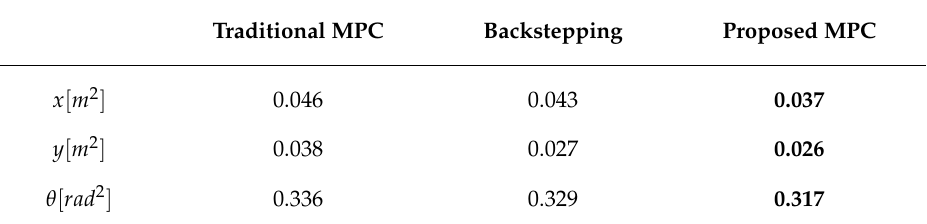
Table 4. MSEs of Tracking square trajectory based on different control